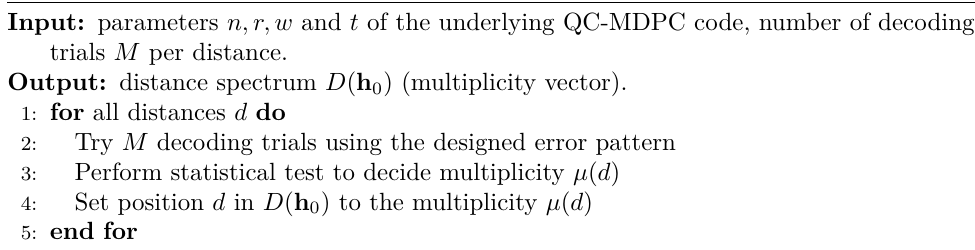
Algorithm 1 Computing the distance